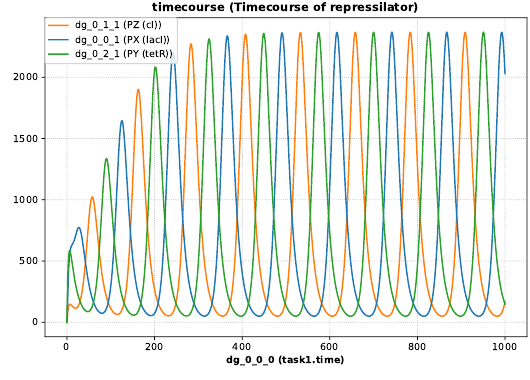
Figure 1.2: Time-course simulation of the repressilator depicting repressor pro- teins lacI, tetR and cI. Simulation with tellurium